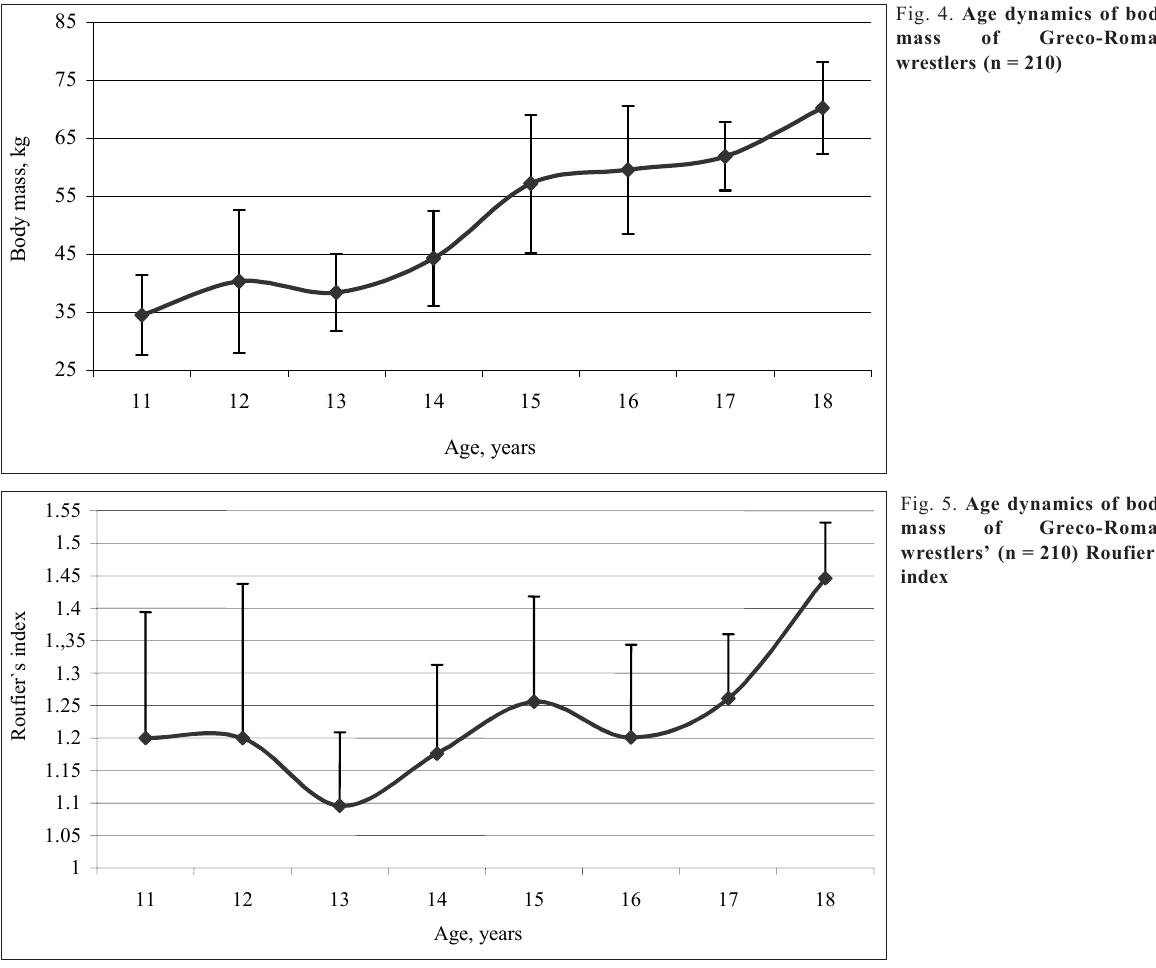
Fig. 4. Age dynamics of body mass